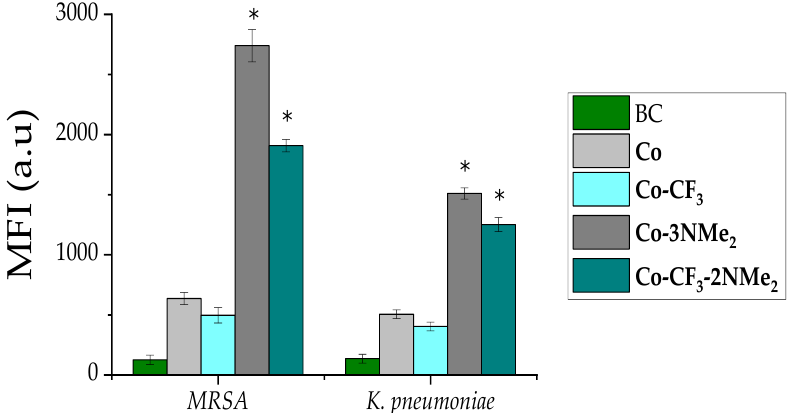
Figure 5. Intracellular ROS production upon PDI. Mean fluorescence intensity (MFI) for in MRSA (left bars group) and K. pneumoniae (right bars group). Bacteria control (BC) solely under light is shown in green, and the following colors represent each compound: dark gray, Co-3NMe 2 ; dark cyan, Co- CF 3 -2NMe 2 ; light gray Co; and light cyan Co- CF 3 . Results are represented as the mean ± standard deviation of 3 replicates performed on three independent days. * represents a p -value of 0.05 or lower which is considered statistically significant with respect to the control.